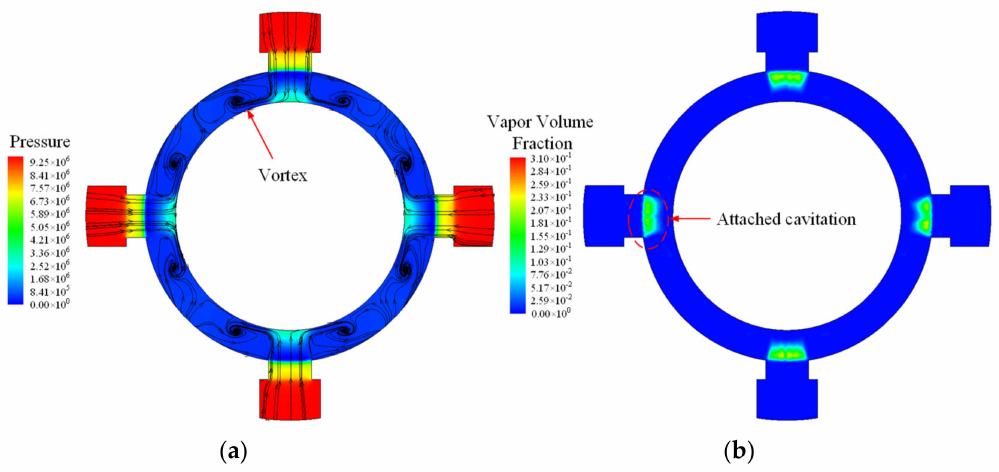
Figure 11. Demonstration with higher back pressure: ( a ) Pressure contour and streamlines; ( b ) Vapor phase contour.